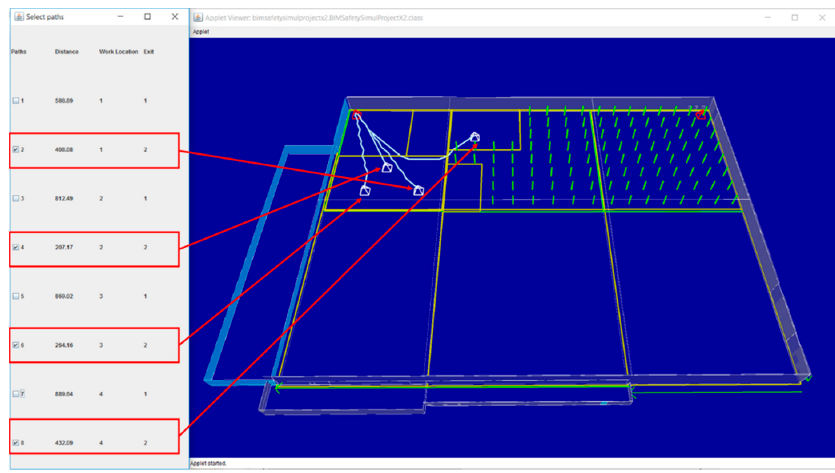
Figure 14. Selected evacuation paths found from scenario 1.